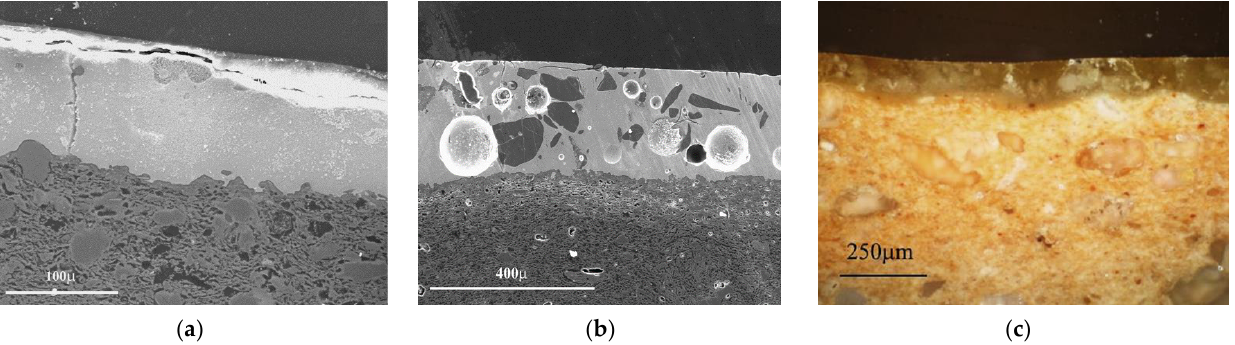
Figure 4. Tin-opacified glazed ceramics: ( a ) Secondary electron-SEM image of the main-side glaze with cassiterite crystals scattered in the glaze; ( b ) Secondary electron-SEM image of the secondary side with non-plastic inclusions; ( c ) Optical Microscopy image of the secondary-side glaze.